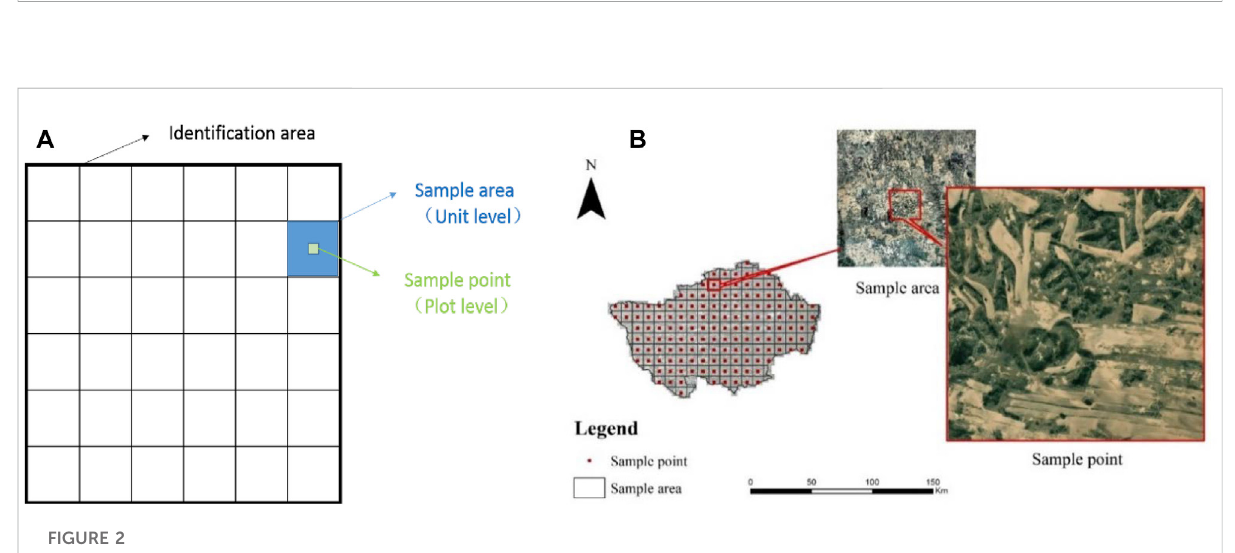
FIGURE 2 Diagram of the sample layout. (A) Scale construction; (B) sample